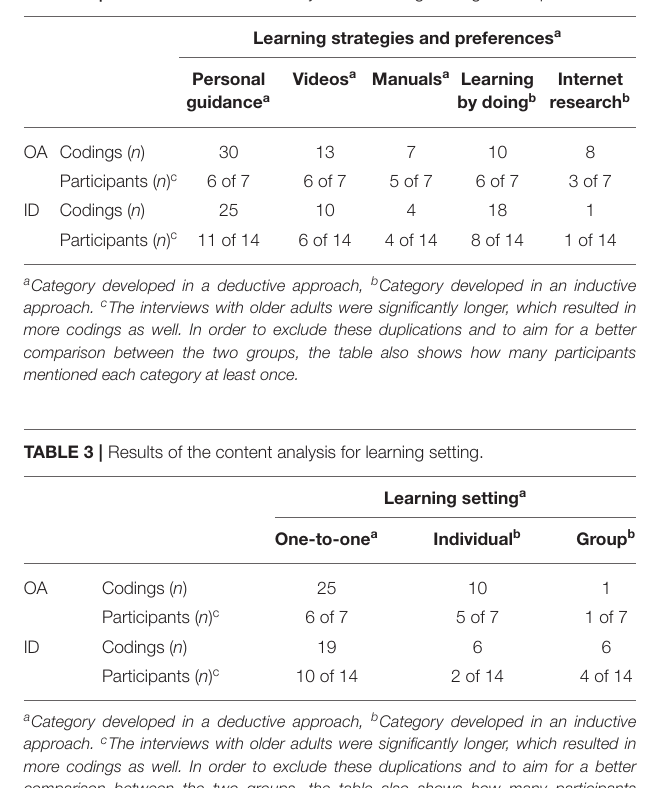
TABLE 1 | Sample characteristics. TABLE 2 | Results of the content analysis for learning strategies and preferences.